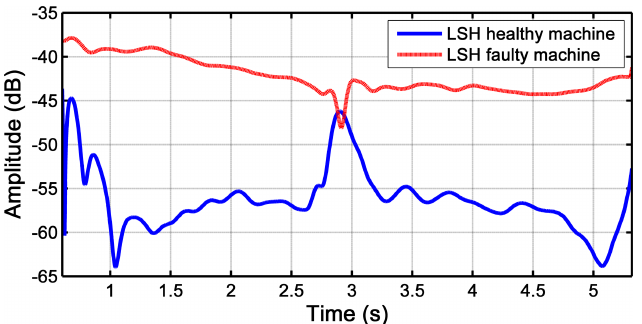
Figure 15. Amplitude of the LSH due to the broken rotor bar during the start-up of a healthy and faulty machine extracted from Figure 14. The average value of the LSH of the healthy machine (blue line) is − 56.36 dB and of the faulty machine (red line) is − 41.67